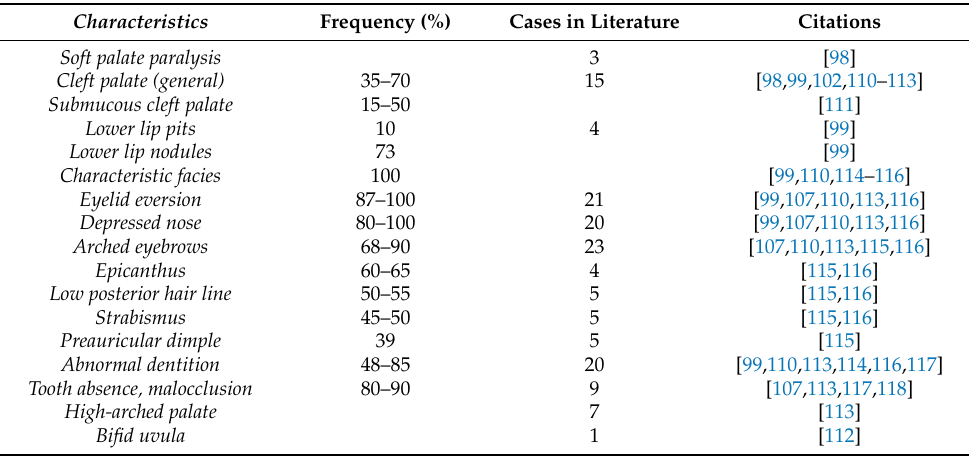
Table 2. Craniofacial dysmorphism in KS patients reported in the